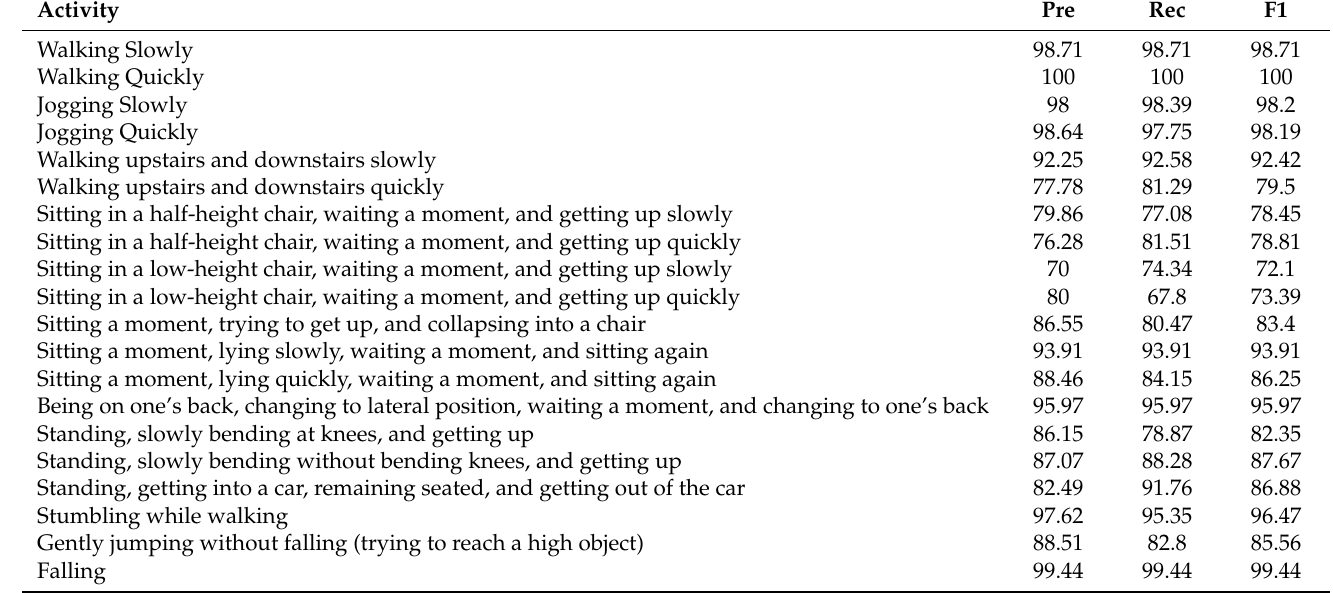
Table 9. Classification rates (%) of the best model of the SisFallM dataset using RF.